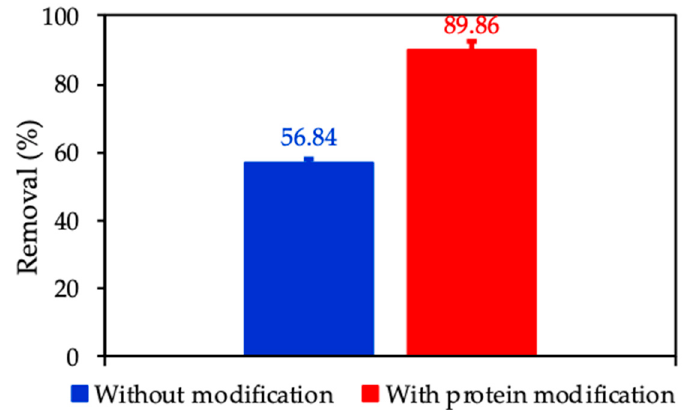
Figure 15. Removal of CFX using nanosilica without and with protein modification. Error bars show standard deviations of three replicates.